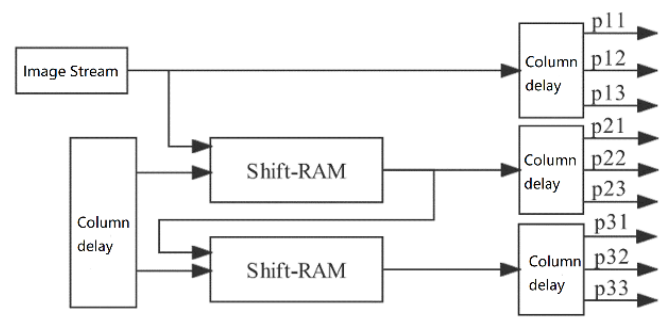
Figure 5. Block diagram of the 3 × 3 window extraction window.